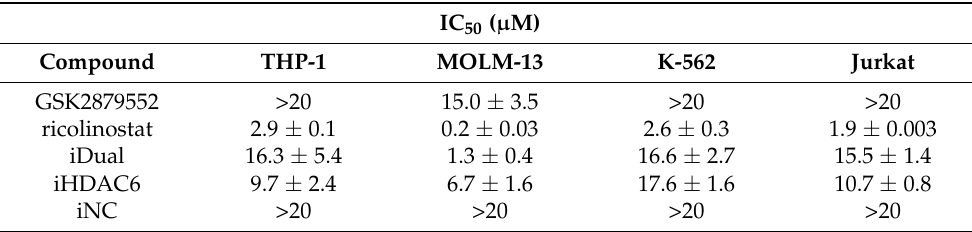
Table 2. Leukemia cell viability measured by the ATP-dependent cell titer-glo assay. IC 50 values are normalized relative to control cells ± standard deviation from three biological